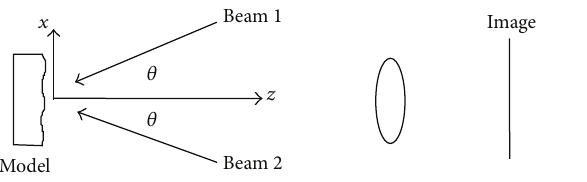
Figure 1: In-plane speckle interferometry.